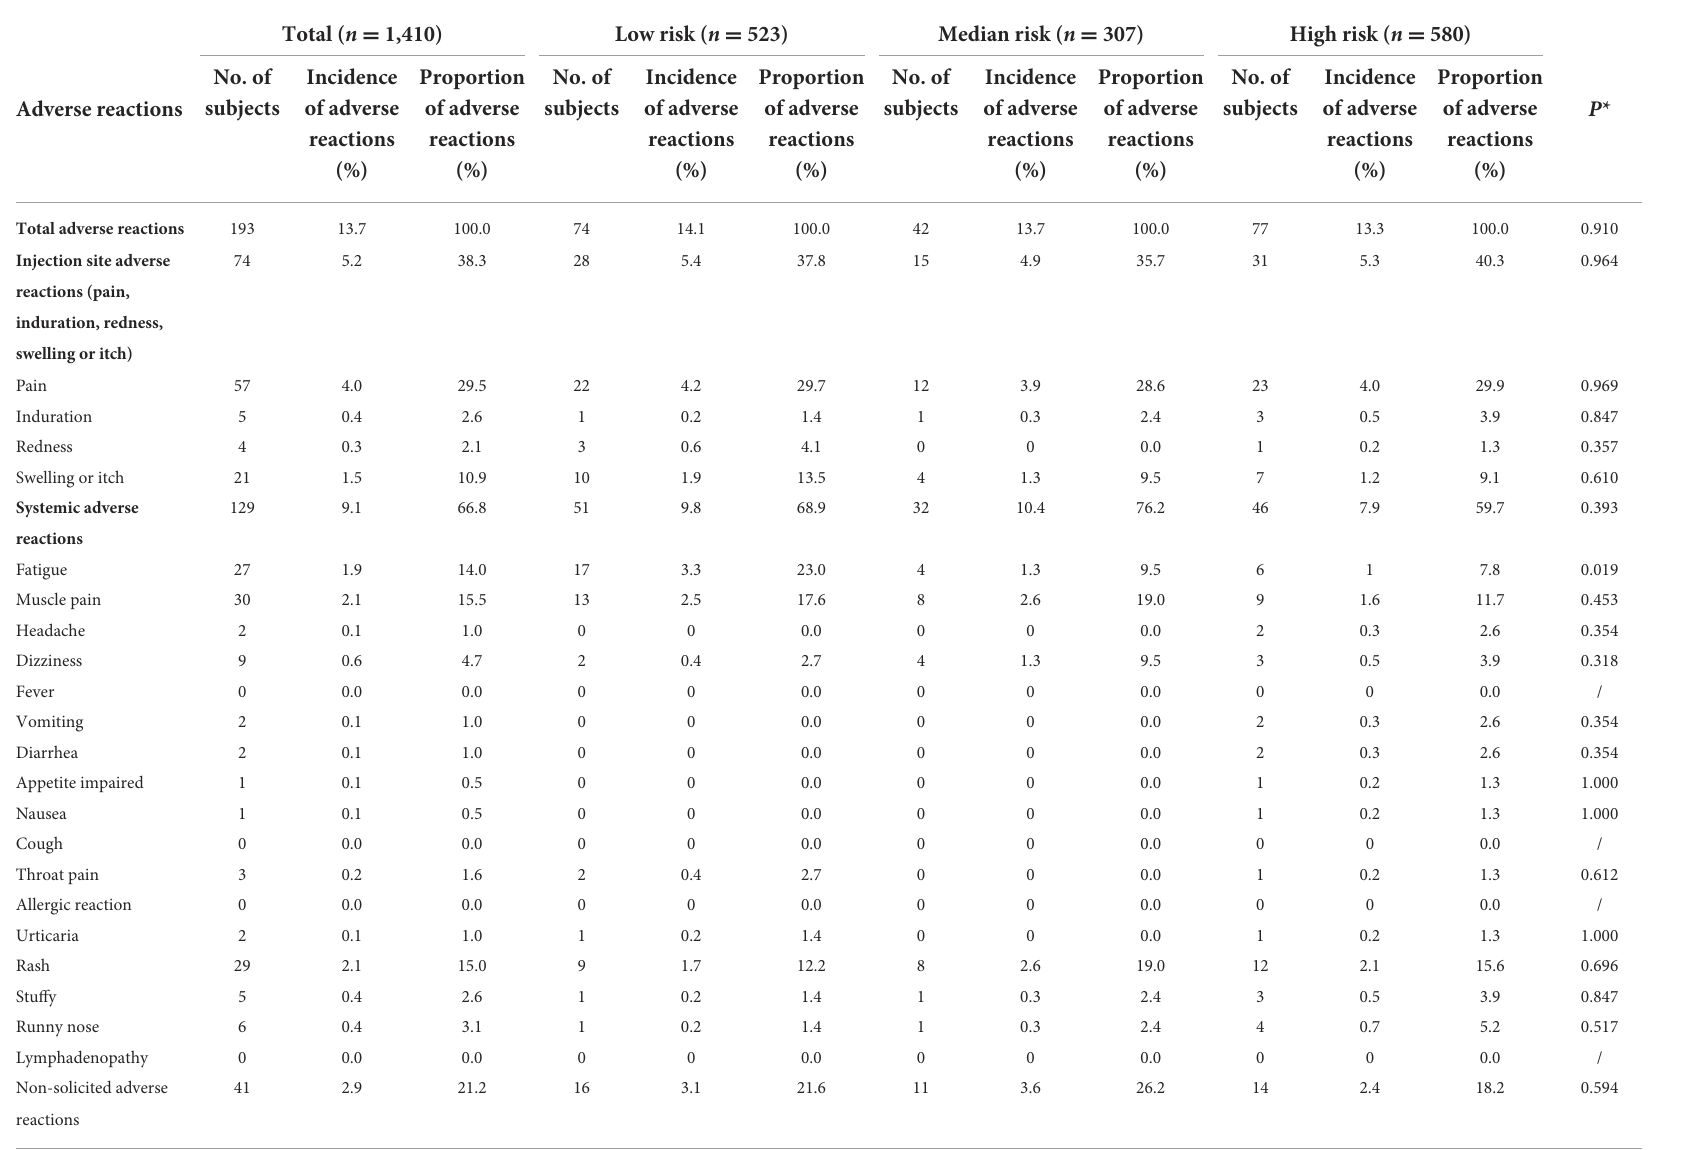
TABLE 3 Distribution of multiple types of adverse reactions after second